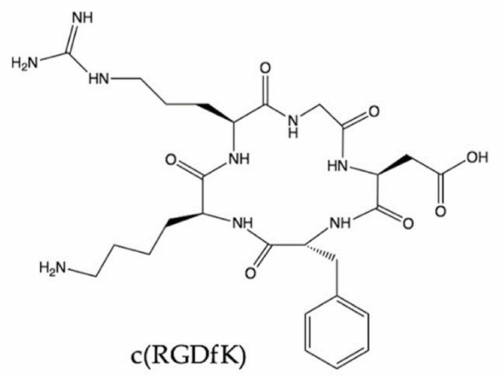
Figure 2. Cyclo(-RGDfK), a potent and selective inhibitor of the α v β 3 integrin, with an IC 50 of 0.94